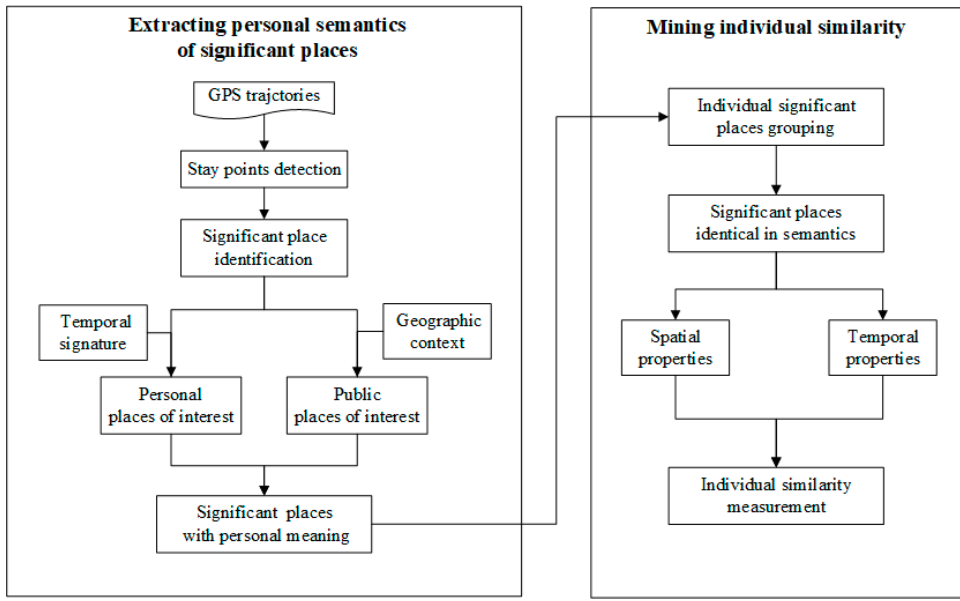
Figure 1. The proposed framework for mining individual similarity.